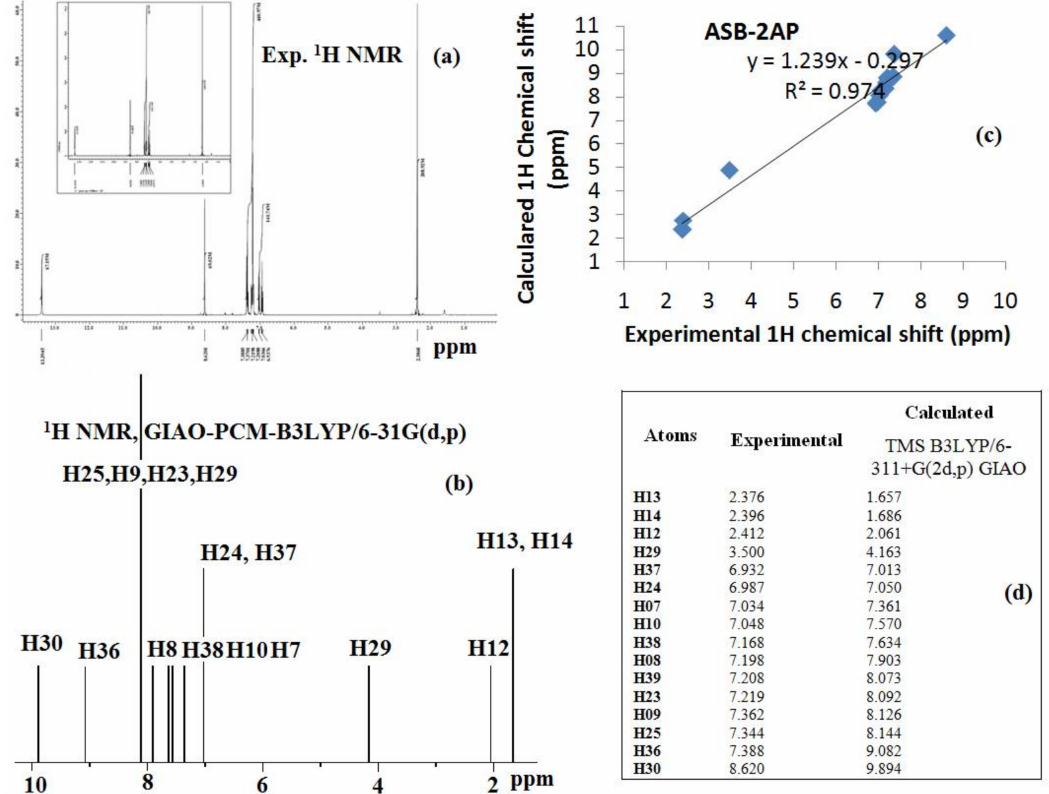
Figure 6. Comparison of ( a ) experimental and ( b ) theoretical 1 H-NMR spectra ( c ) correlation graph and ( d ) experimental and calculated 1 H chemical shifts (ppm) of ligand,